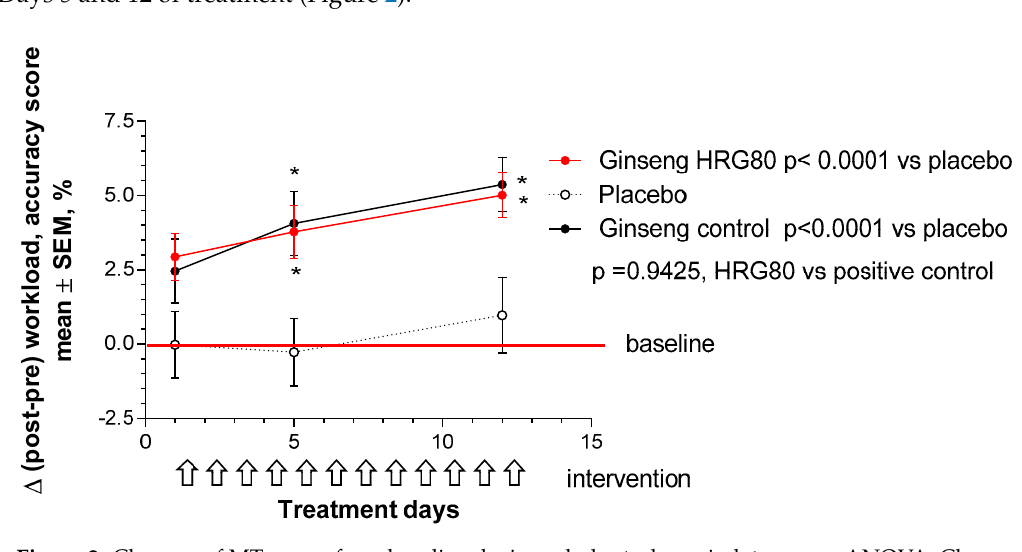
Figure 2. Changes of MT scores from baseline during whole study period; two-way ANOVA. Change in memory with time at Days 0, 1, 5, and 12 in placebo, ginseng HRG80, and ginseng control treatment groups. Significance of changes shown by symbols * p < 0.05, ** p < 0.01, *** p < 0.001l; ns, not significant. Between-group change comparison over time shows significant di ff erence between ginseng HRG80 and placebo treatments ( p < 0.0001, n = 50 in each group), ginseng control, and placebo treatments, but no significant di ff erence between two ginseng treatments.